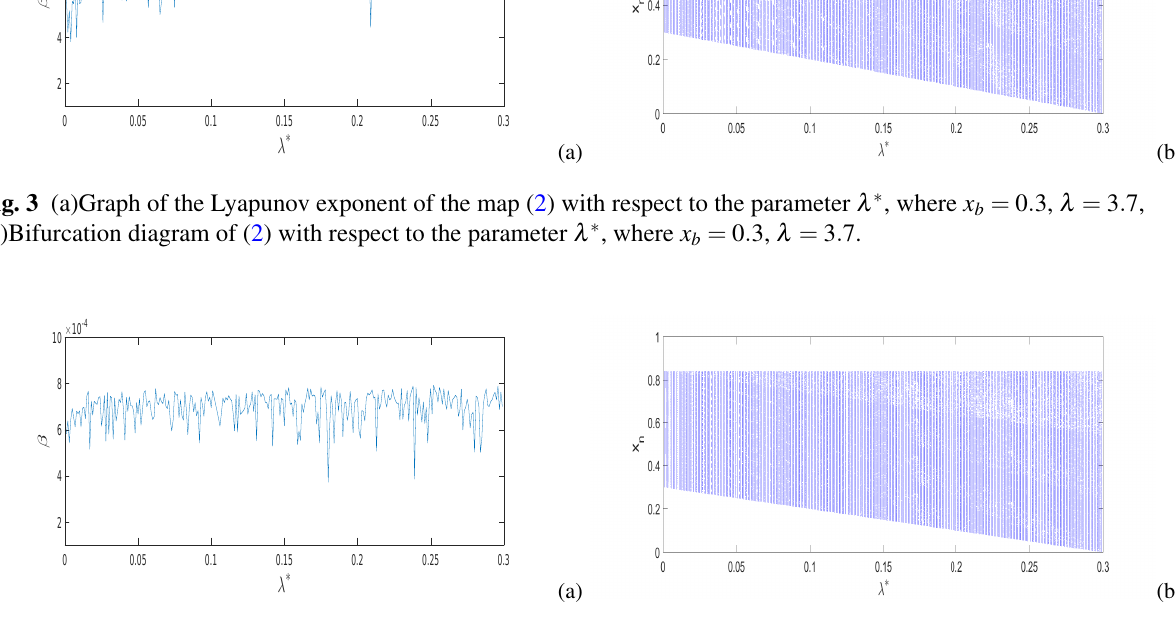
Fig. 4 (a)Graph of the Lyapunov exponent of the map (2) with respect to the parameter λ ∗ , where x b = 0 . 3, λ = 4, (b)Bifurcation diagram of (2) with respect to the parameter λ ∗ , where x b = 0 . 3, λ =